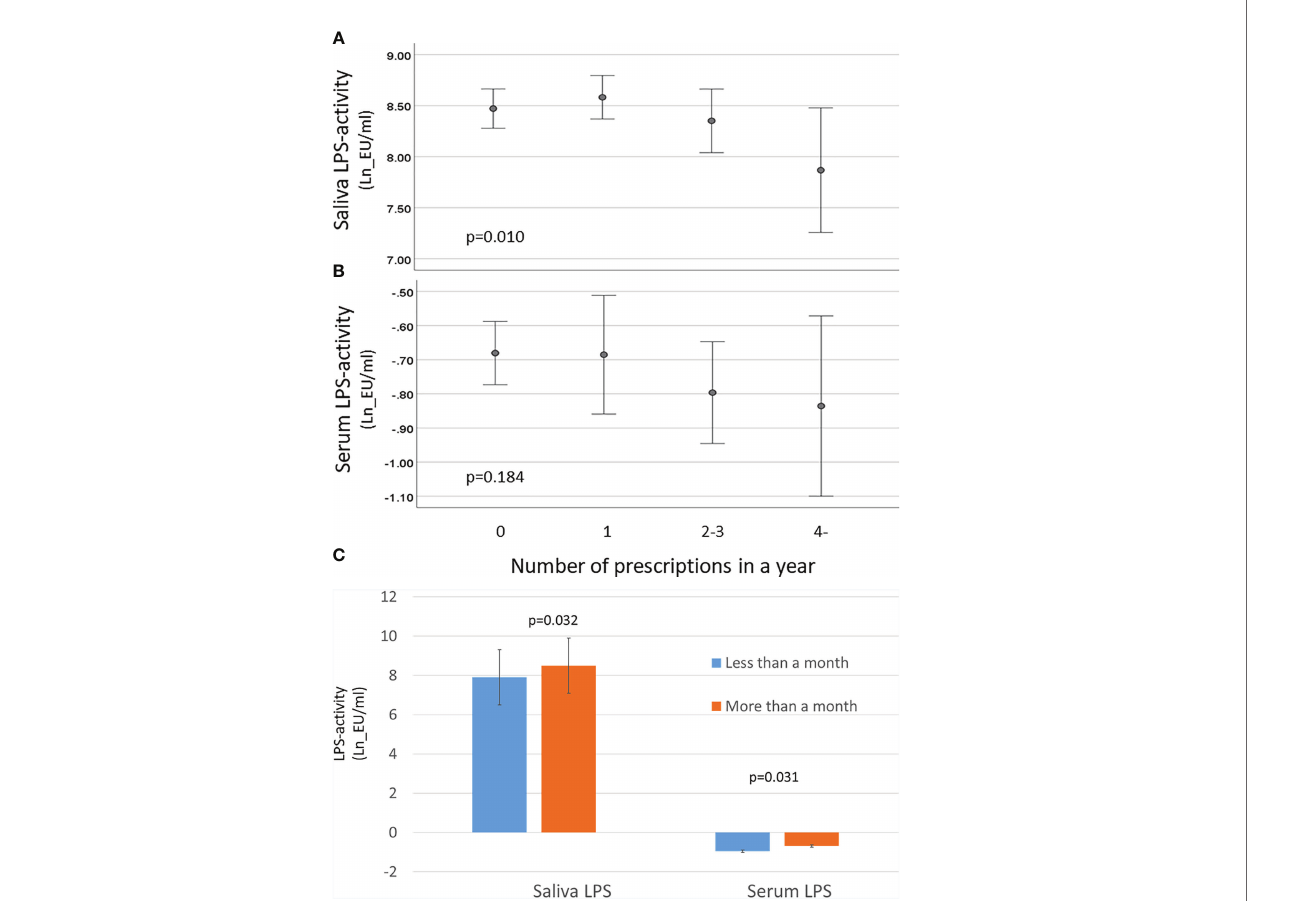
FIGURE 6 | Effect of antibiotics on LPS activity. Saliva and serum LPS activity was determined by LAL assay, and the results were calculated in groups of patients having 0, 1, 2 – 3, or ≥ 4 prescriptions during the preceding year. (A) Mean saliva and (B) serum LPS activity and 95% CI are shown for logarithmically transformed values (Ln). The p-values are for the weighted linear terms from Anova. (C) Mean saliva and serum LPS activity (and SD) in patients having antibiotics within a month vs. more than a month ago with p -values from t -test.